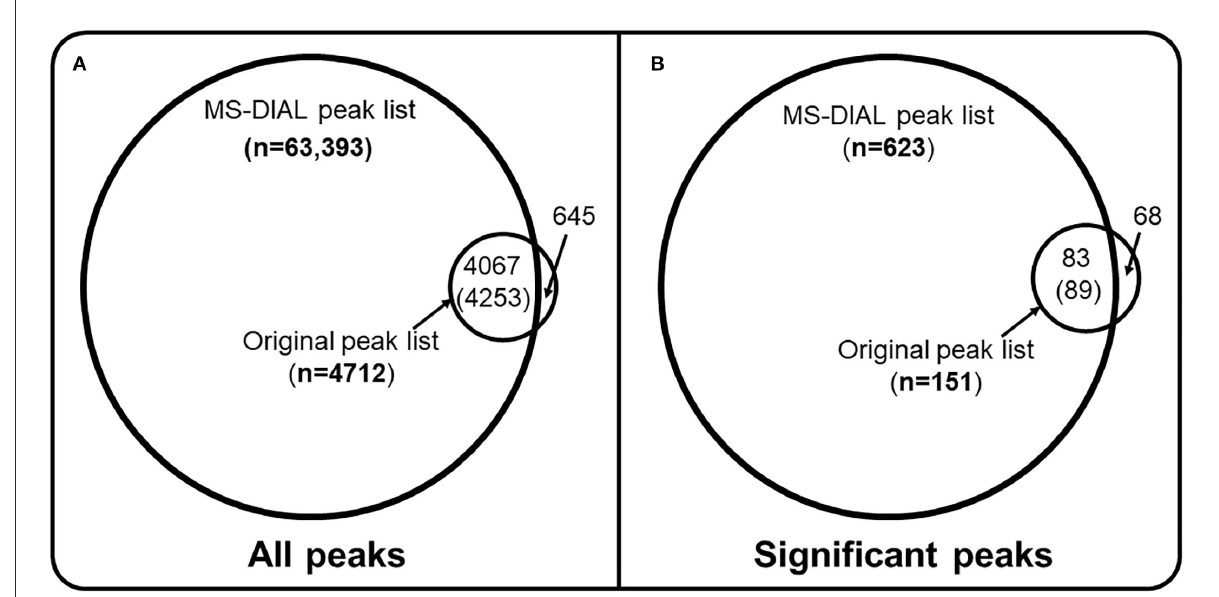
FIGURE1 Data processing thresholds and missed biological insights. (A) all peaks that were generated by the MS-DIAL software for the MTBLS1684 study of 499 cord blood samples (B) only peaks that were found to be significantly correlated (Spearman coefficient) with birth weight at FDR threshold of 0.05. Mass of proton (1.00784) was added to the neutral mass of peaks reported in the original peak list so it could be compared against the MS-DIAL peak-list. A retention time threshold of 0.05min and a mass accuracy threshold of 0.01 Da were used to find if a peak from the original peak list was present in the MS-DIAL generated peak list. Full code is available at https://colab.research.google.com/drive/ 1eV2ywgLtg0RyJ9qzuVl45KGWlmD0JxPy#scrollTo=c38d63Y8pevi. Out of 4,712 peaks from the original peak list, 645 had zero, 3,885 had one, 178 had two and four peaks had three matching peaks in the MS-DIAL data matrix, so a total of 4,253 peaks (4,253/63,393, ∼ 7%) from the MS-DIAL data matrix were covered by the original peak list. Out of 151 significantly associated peaks (B) from the original peak list, 68 had 0, 77 had 1 and 6 peaks had two matching peaks among the 623 significantly associated peaks from the MS-DIAL data matrix (89/623, ∼ 14%